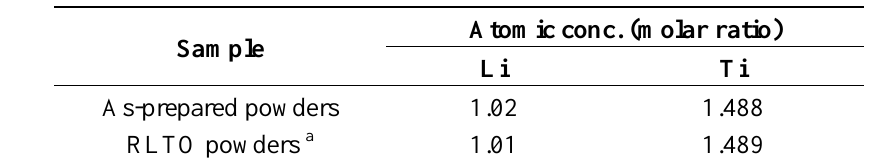
Table 1. Chemical compositions of as-prepared powders and RLTO powders calcined at 1100  C.